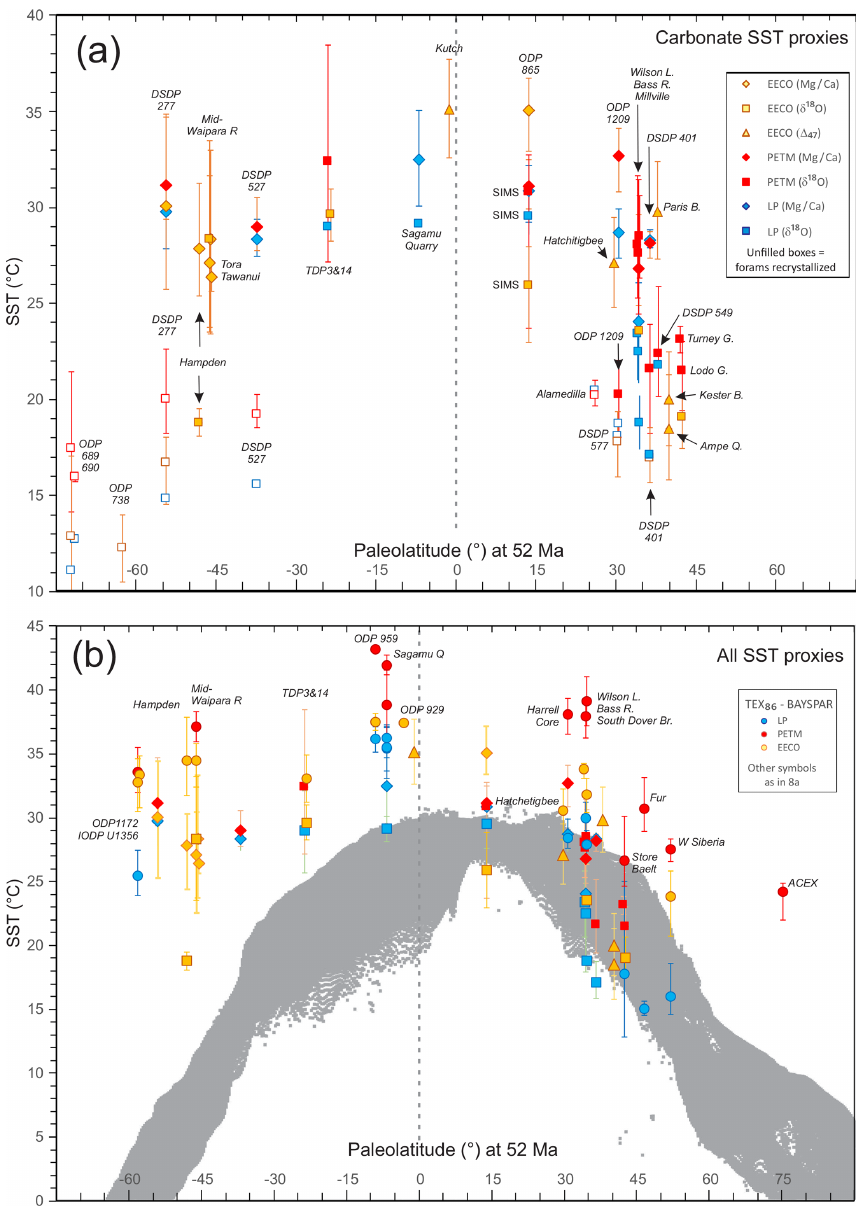
Figure 8. SST estimates derived from (a) carbonate proxies and (b) all proxies for three time slices: latest Paleocene (LP), PETM and EECO. Deep-sea δ 18 O records that are inferred to be affected by diagenesis are omitted from Fig. 8a. These data are tabulated in Supplement Data Files 3–6. Grey data cloud in Fig. 8b represents modern SST measurements derived from European Centre for Medium-Range Weather Forecasts (2017), ERA5 Reanalysis Monthly Means, from https://rda.ucar.edu/datasets/ds630.1/ (last access: 19 July 2019), Research Data Archive at the National Center for Atmospheric Research, Computational and Information Systems Laboratory in Boulder, Colorado (updated monthly; last access: 8 November